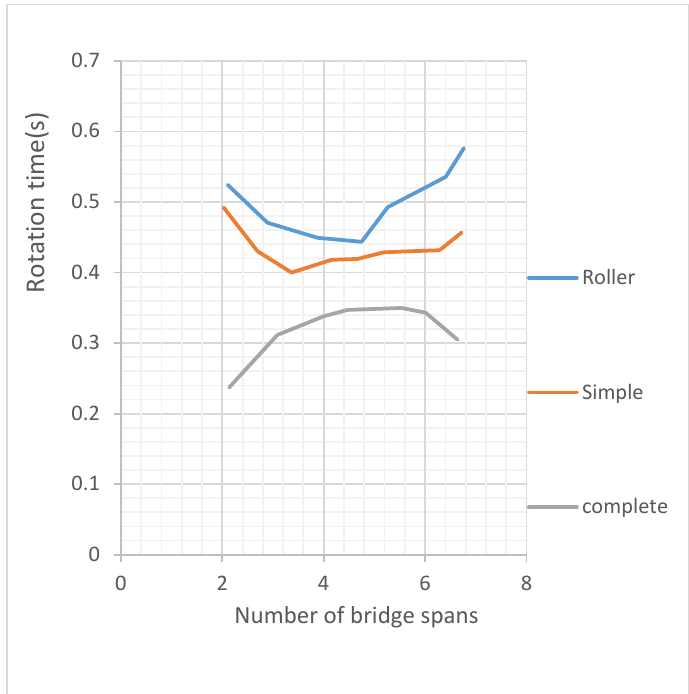
Fig. 11. The fundamental period of transverse vibration in bridges with a base height of 6 m.